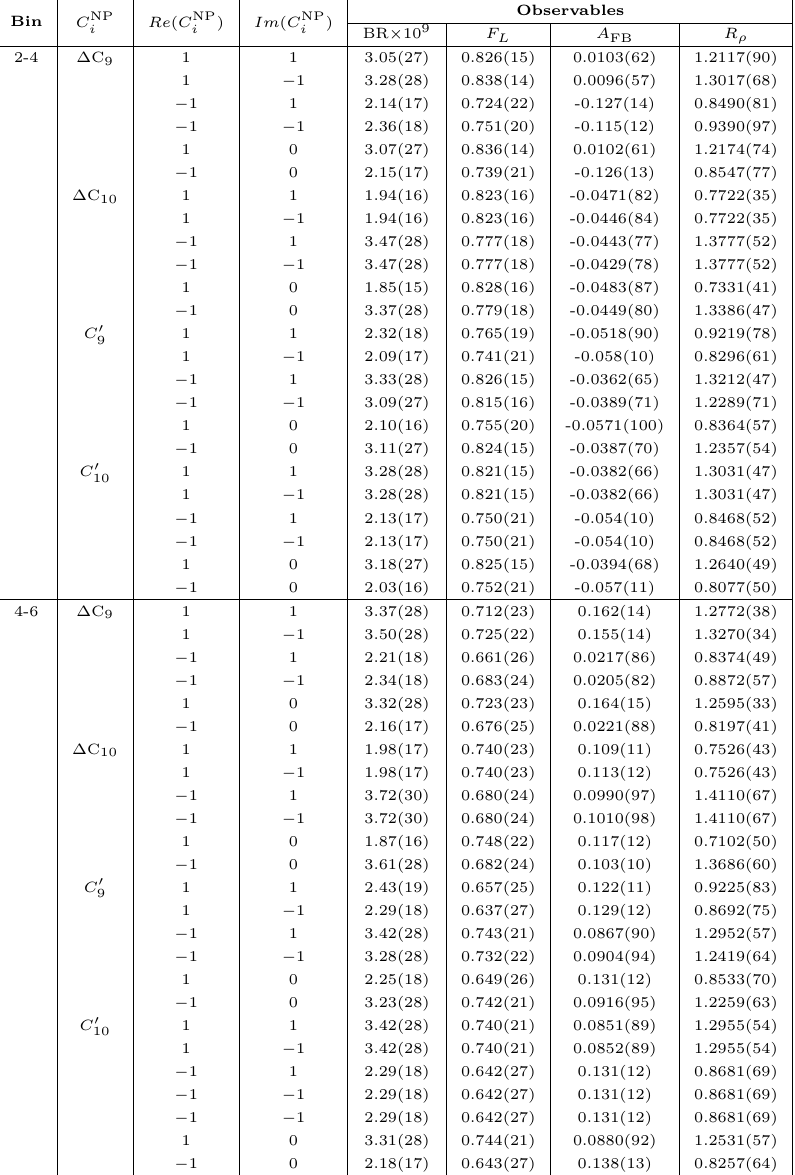
and C 0 for the 9 , 10 9 , 10